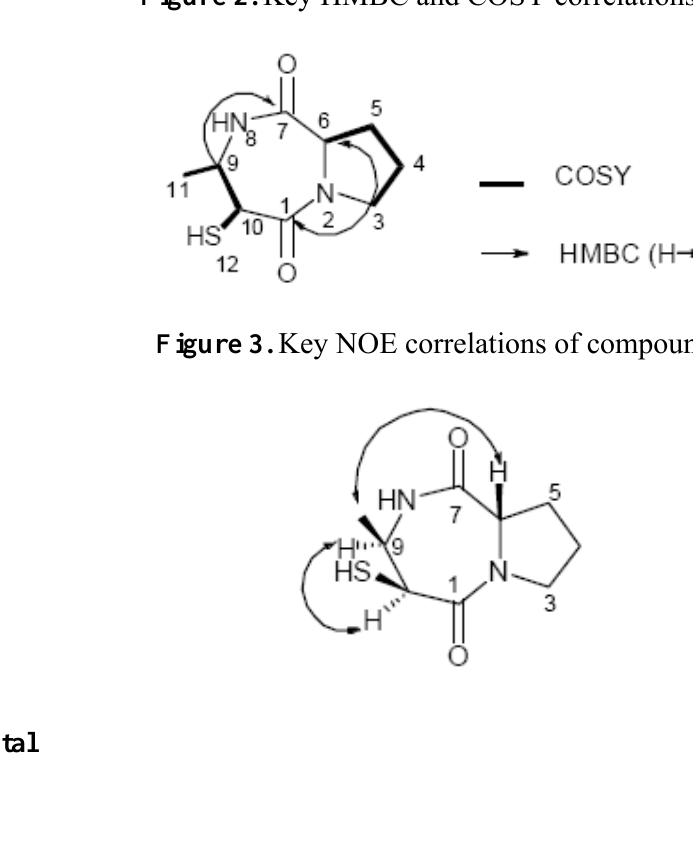
Figure 2. Key HMBC and COSY correlations of 1 .